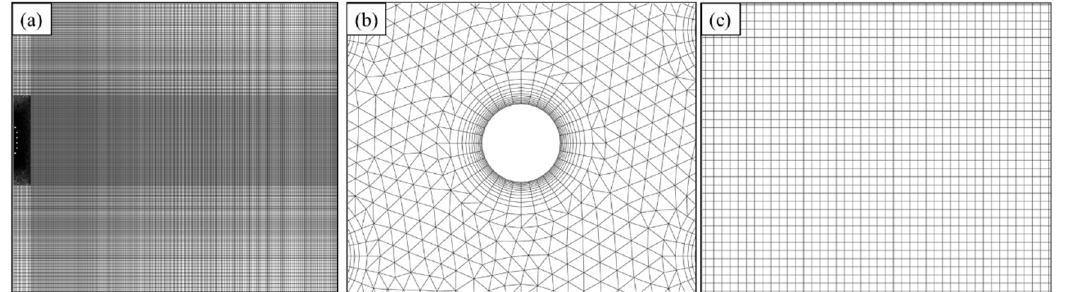
Figure 2. Computational grid for the cases of D = 22 cm and 𝜙 = 0.1: ( a ) a close view of the wake area grid, ( b ) a detailed view of the grid near the circular hole, and ( c ) a feature view of the grid near the wake behind the vegetation patch.